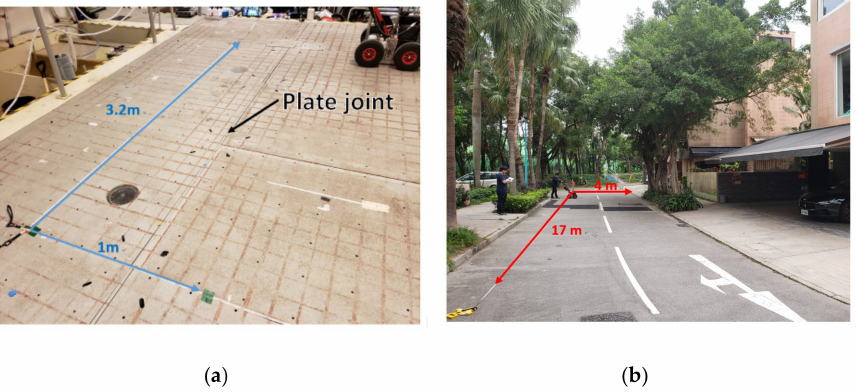
Figure 8. Illustrations of test sites: ( a ) laboratory test; ( b ) field